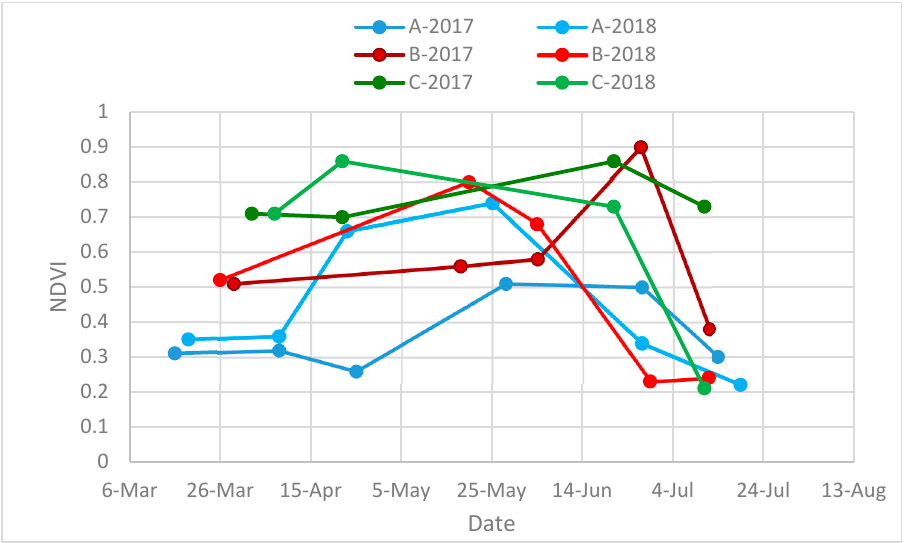
Figure 4. Mean values of NDVI values for six fields (three locations: A—Bro ż ówka, B—Zdziechów, and C—Kry ł ów in two years: 2017 and 2018). Table 4. Mean values and ±SD of vegetation indices for the dates when the highest NDVI values were observed.